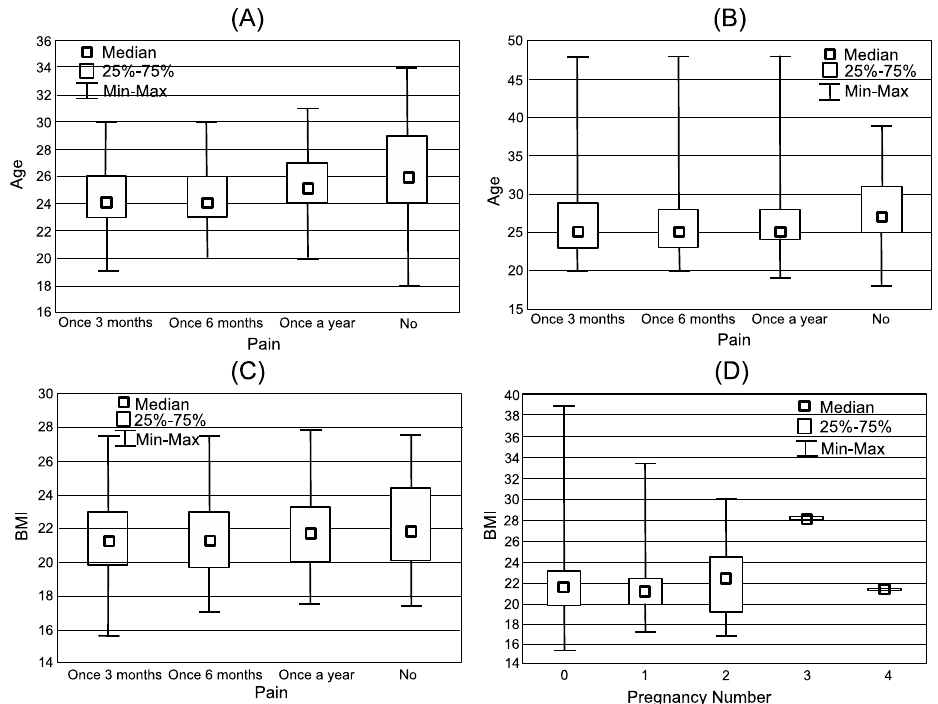
Figure 3. Box plot representation of the distribution of women ( A ) Age vs. pain frequency—never pregnant; ( B ) Age vs. pain—ever pregnant; ( C ) BMI vs. Pain—never pregnant; ( D ) BMI vs. Pain-ever pregnant.